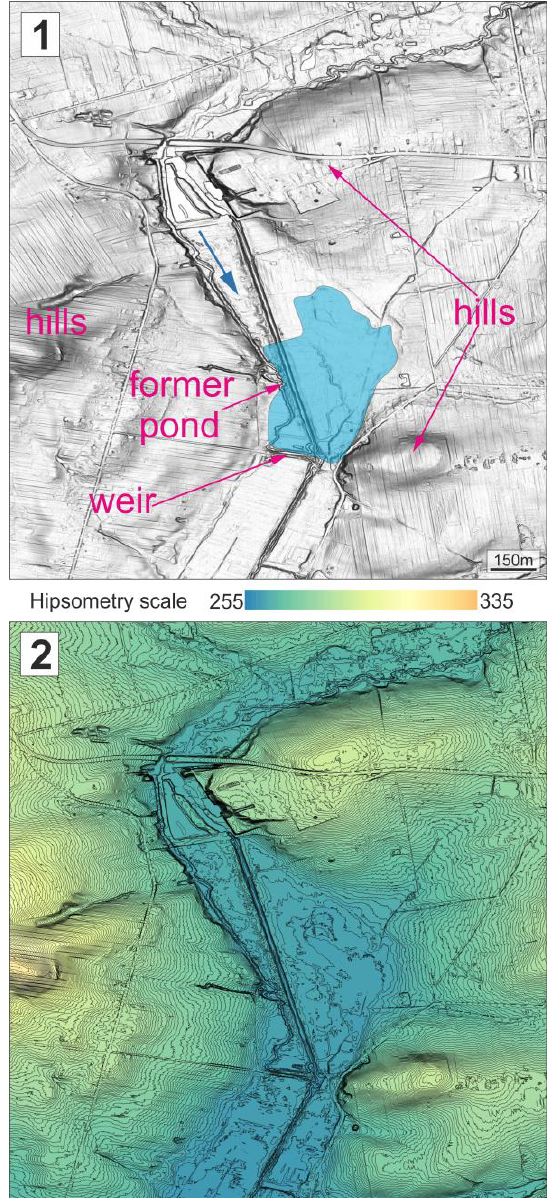
Fig. 2. Location of the Bobrza former ironworks: 1 – on the shaded relief map; 2 – on the coloured contour